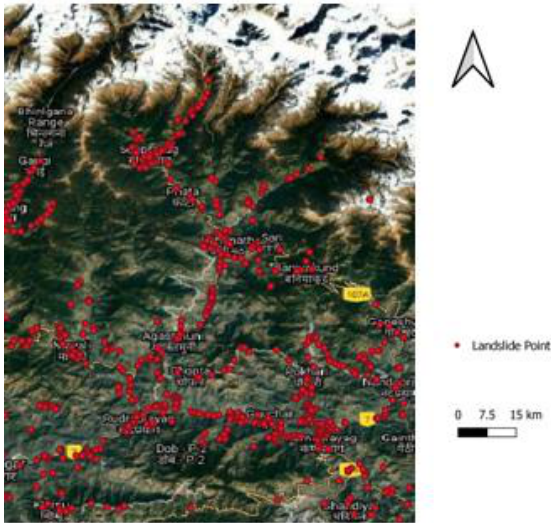
Figure 4. Location of Landslides (red points) obtained from BHUKOSH